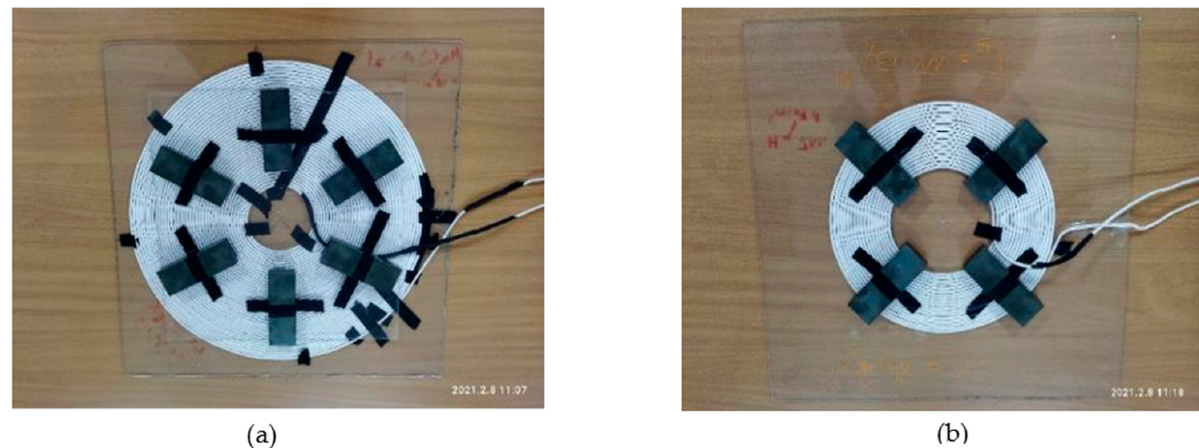
Figure 20. Fabricated coils: ( a ): Coil1, ( b ): Coil2 and ( c ): Coil3.